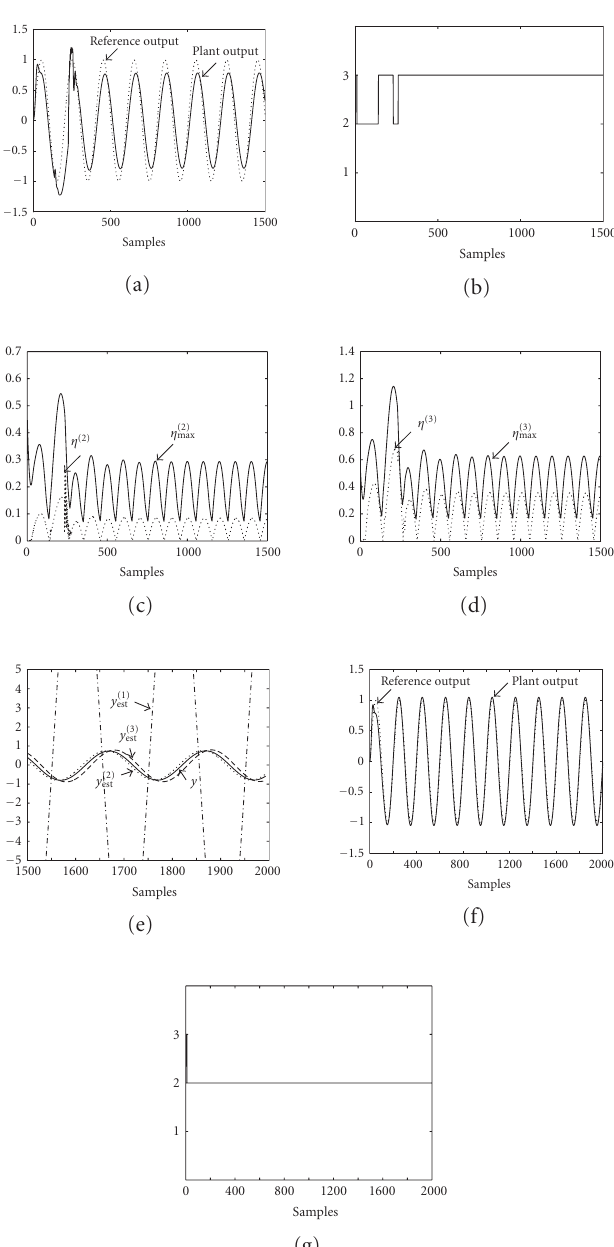
Figure 4.2. (a) Plant and reference outputs with α k = 0 . 95. (b) Active controller. (c) Contribution of the unmodeled part in the second model and the applied upper bounds. (d) Contribution of the unmodeled part in the third model and the applied upper bounds. (e) Estimated outputs over the last 500 simulation samples. (f) Plant and reference outputs with α k = 0 . 995. (g) Active